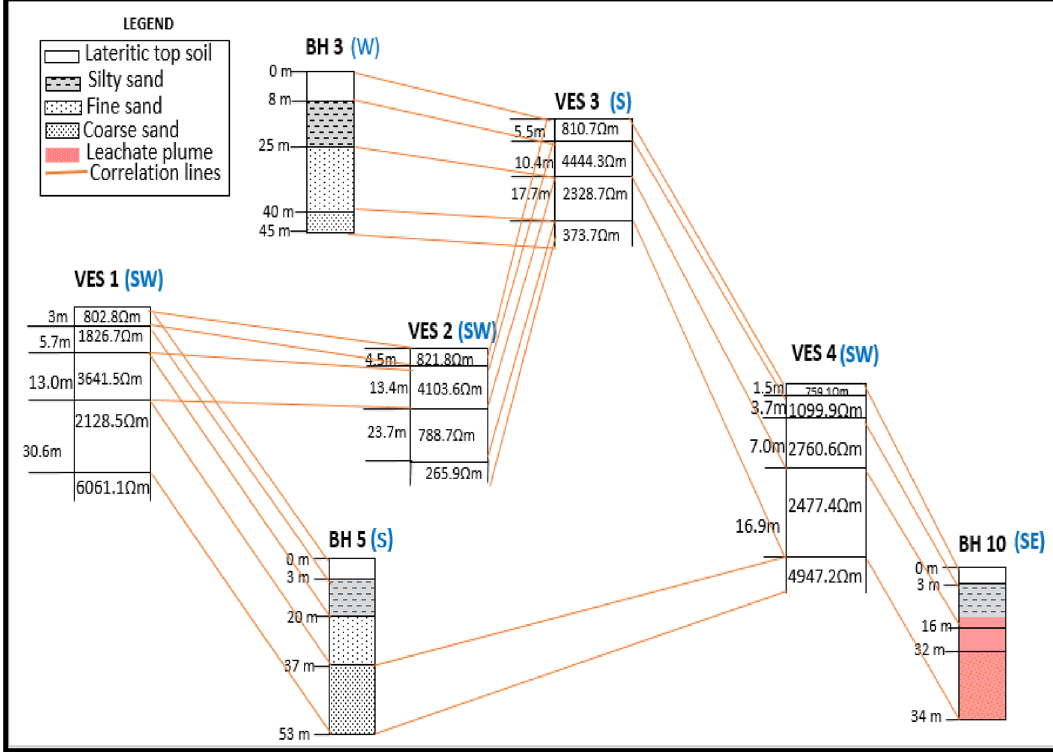
Figure 10. Schematic correlation of the geoelectric layers from the 4 VES and borehole logs across the study area, where the pink colour indicates borehole affected by the leachate plume. BH